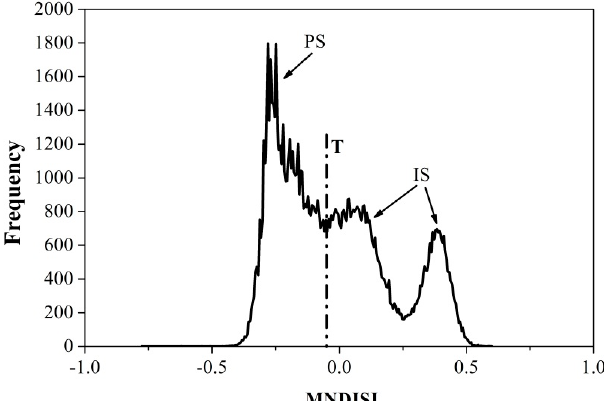
Figure 2. An example of automatically selected threshold ( T ) in the MNDISI histogram for segmenting impervious surface (IS) and pervious surface (PS) pixels.